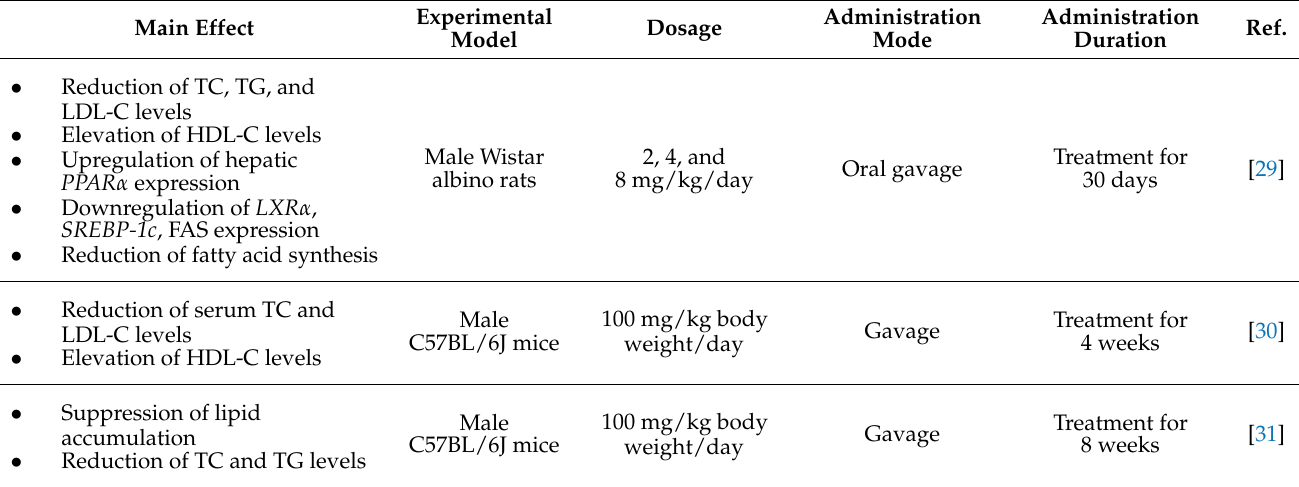
Table 1. The effects of sesamol and its derivatives on serum lipid